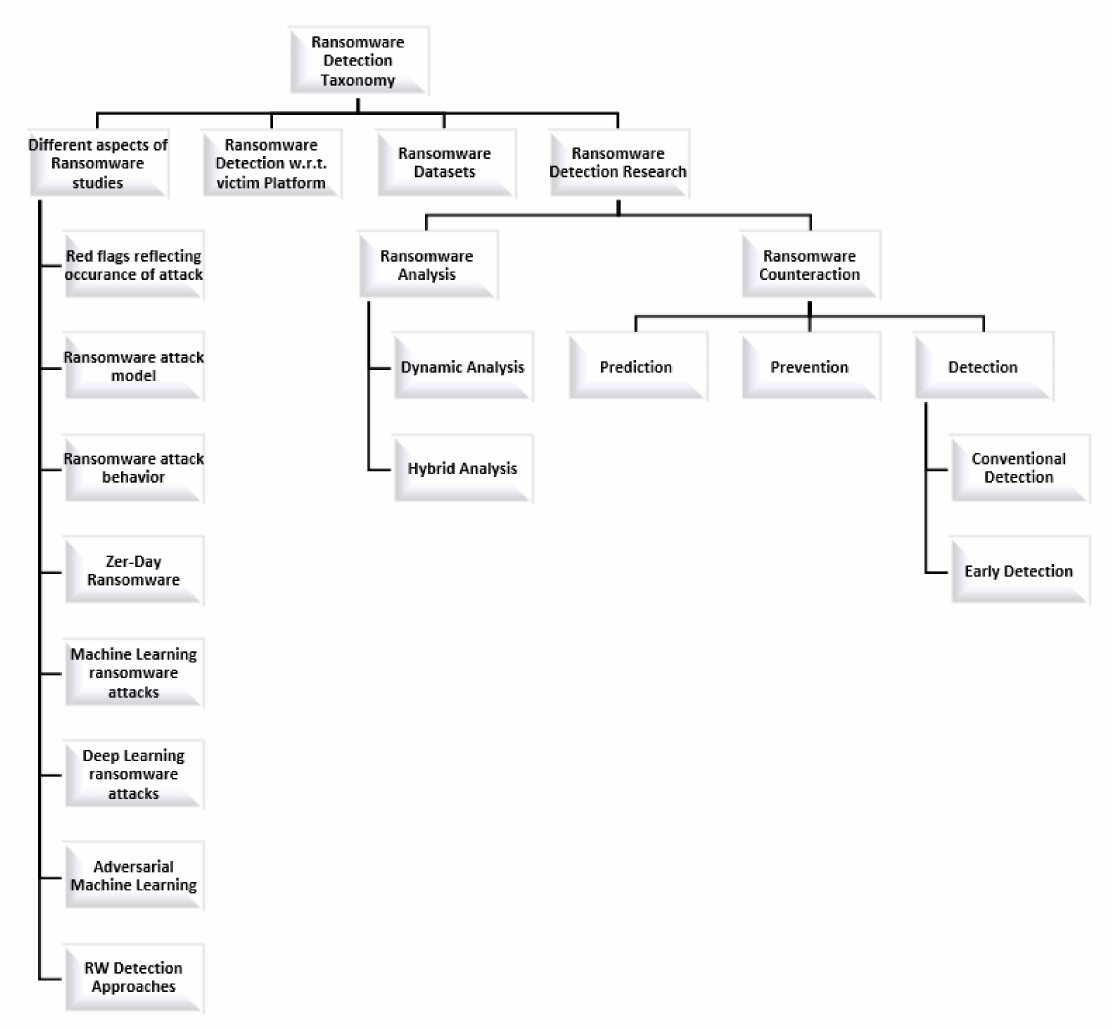
Figure 1. Taxonomy of ransomware detection studies utilizing ML and